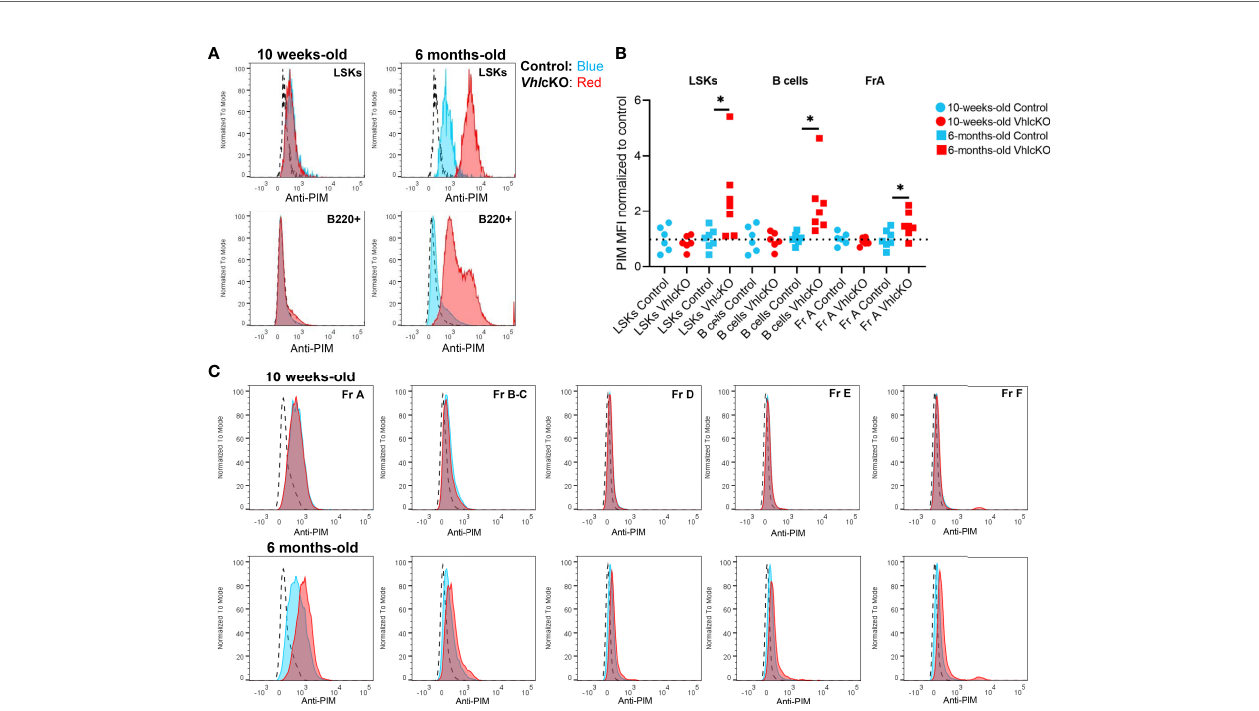
FIGURE 8 | Hypoxia cell marker pimonidazole indicates difference by age and amongst B cell fractions in control and VhlcKO mice. Vhl cKO and control mice were injected with PBS or 120 mg/kg pimonidazole (PIM). PIM staining of (A) Live, Lin-, CD45+, Sca1+, cKit+ (LSKs) (top) and Live, B220+ cells (bottom) in the BM of 10- weeks-old and 6-months-old mice; dashed line: isotype control; blue line: anti-PIM staining in controls; red: anti-PIM staining in Vhl cKO; (B) summary of PIM staining in Vhl cKOs (red) normalized to the mean fl uorescence intensity (MFI) in controls (blue); results from 4 independent experiments are shown; (C) representative anti- PIM staining plots of individual B cell Fractions (A – F) from a control (blue) and a Vhl cKO mouse (red) at 10-weeks-old (top) and at 6-months-old (bottom). *p<0.05, two-tailed student's